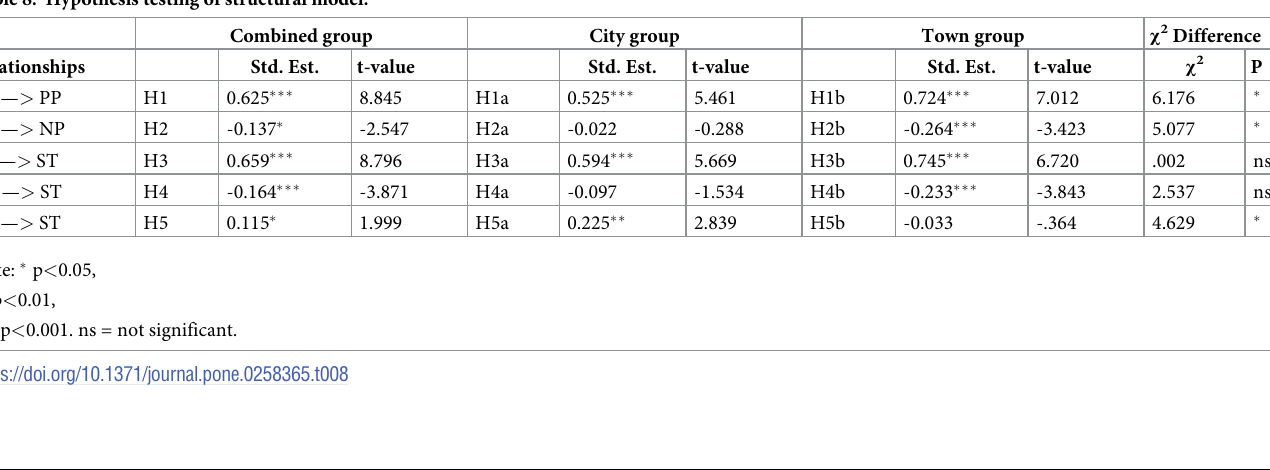
The mediating effects of residents’ PP and NP on the association between their PA and ST